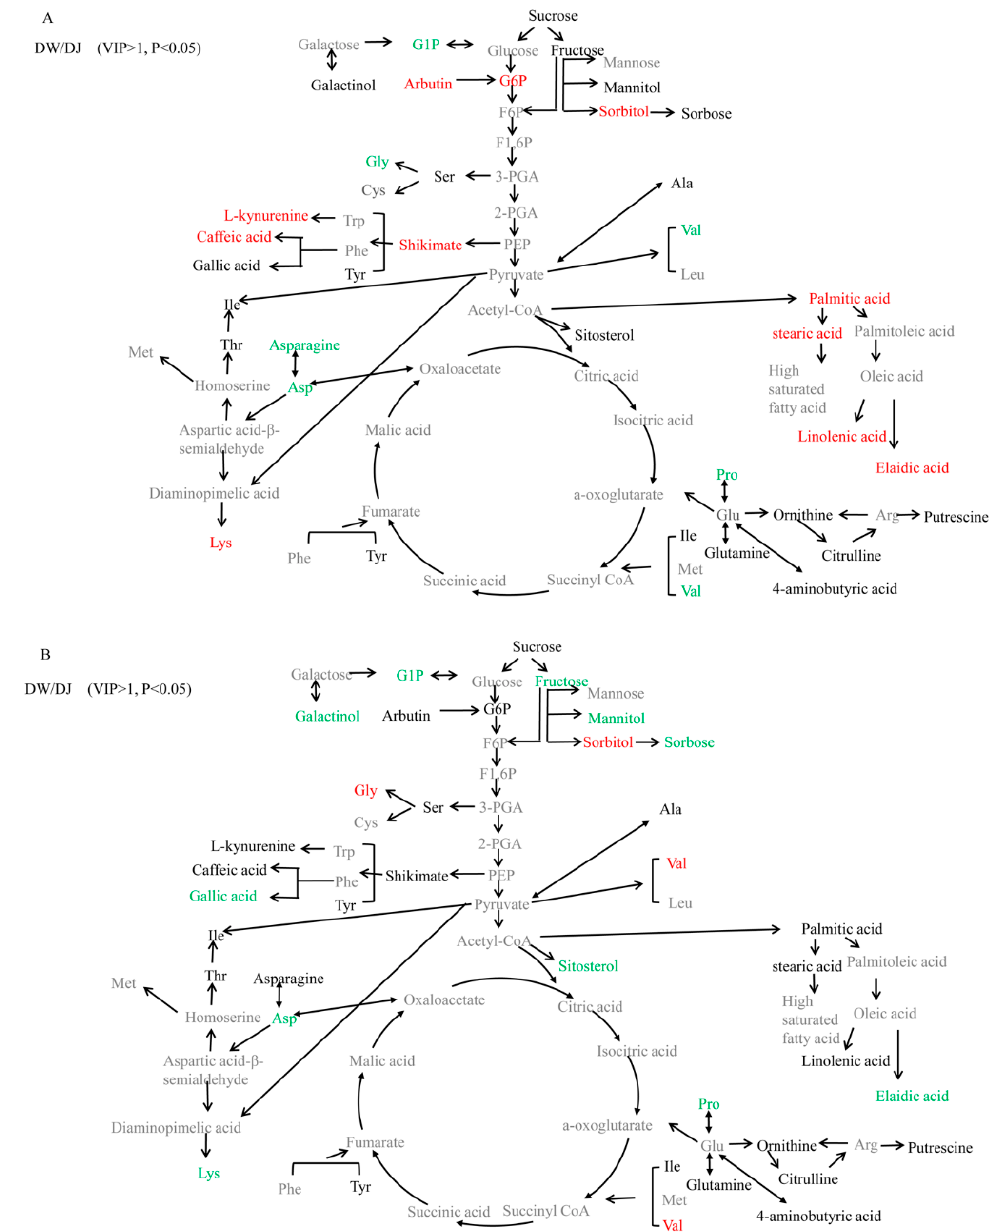
Figure 4. Changes in metabolites in DW and DJ shown in a metabolic diagram. ( A ) The changes at 47 DAPs; ( B ) The changes at 63 DAPs. The metabolites with red characters were detectable and exhibited higher content in DW than in DJ. The metabolites with labelled in green were detectable but with lower content in DW than in DJ. The metabolites with black characters were detectable. The metabolites with grey characters were undetectable. G1P, glucose-1-phosphate; G6P, glucose-6-phosphate; F6P, fructose-6-phosphate; F1,6P, fructose-1,6-diphosphate; 3-PGA, 3-phosphoglyceraldehyde; 2-PGA, 2-phosphoglyceraldehyde; PEP, phosphoenolpyruvate; Gly, glycine; Cys, cysteine; Ser, serine; Trp, tryptophan; Phe, phenylalanine; Tyr, tyrosine; Ile, isoleucine; Thr, threonine; Met, methionine; Asp, aspartate; Lys, lysine; Ala, alanine; Val, valine; Leu, leucine; Glu, glutamate; Pro, proline; Arg, arginine.